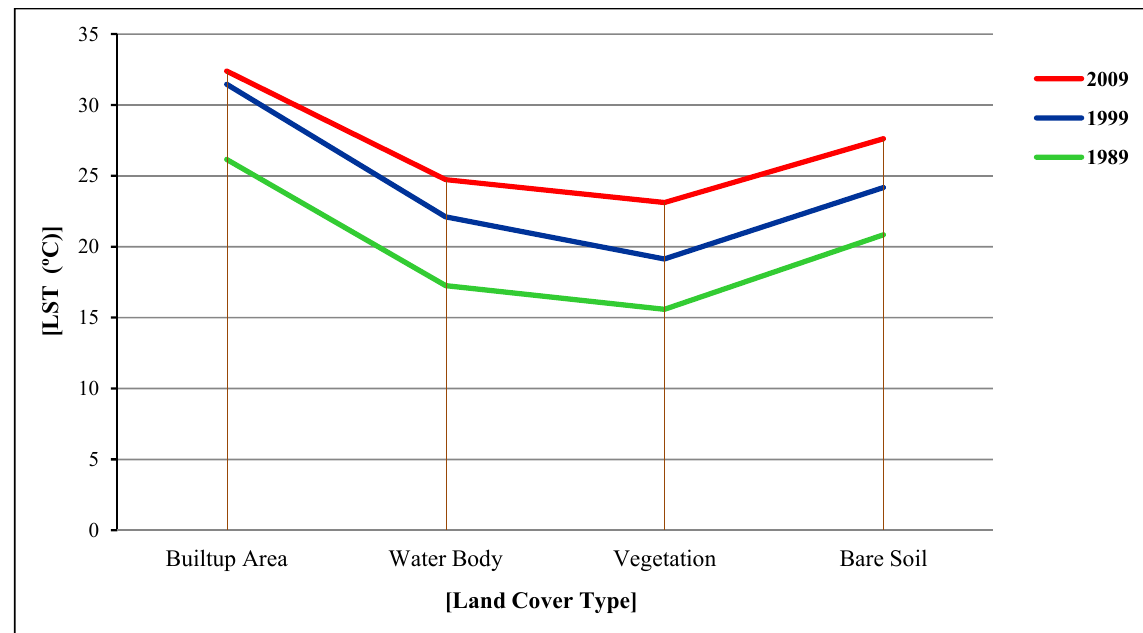
Figure 10. The variations of mean LST over different land cover